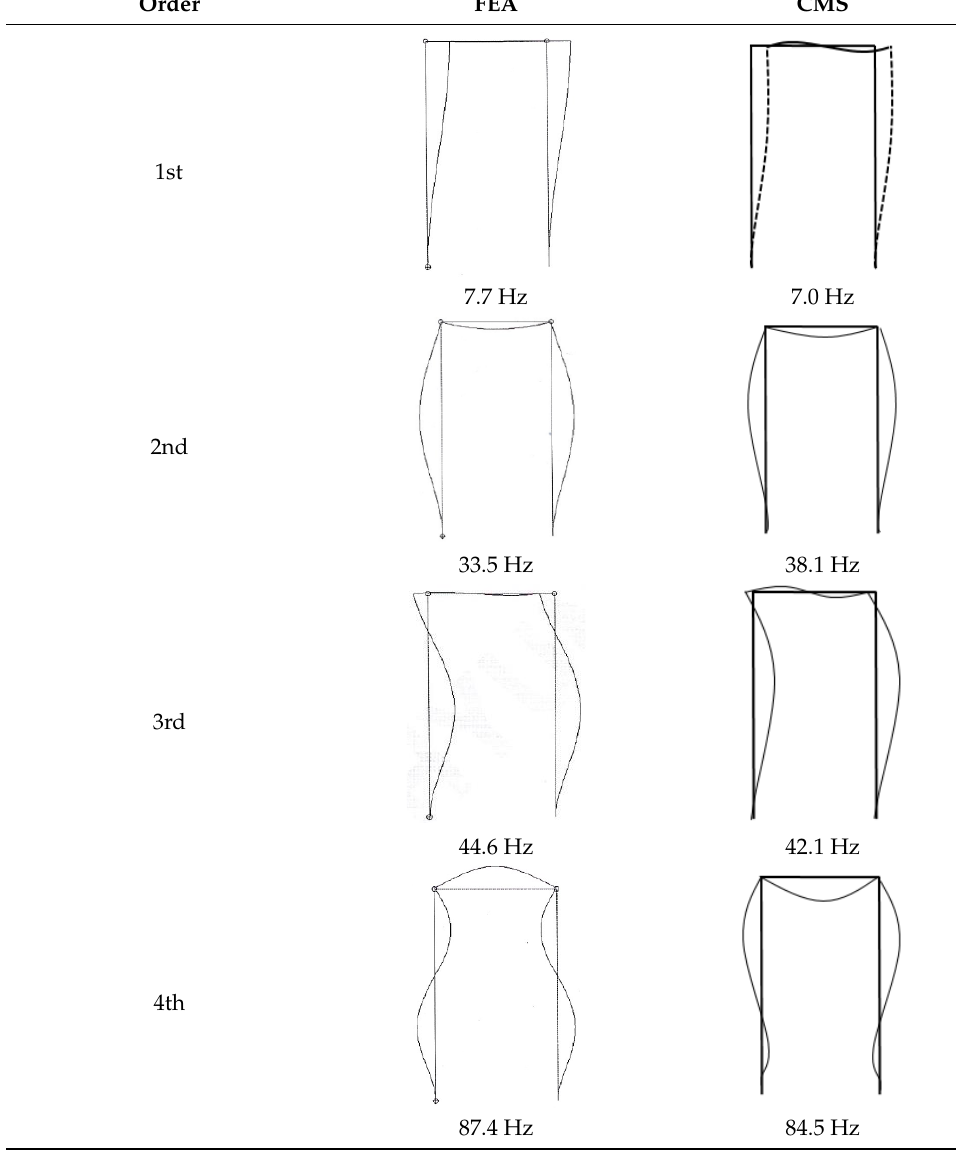
Table 7. The case of study for two components type.